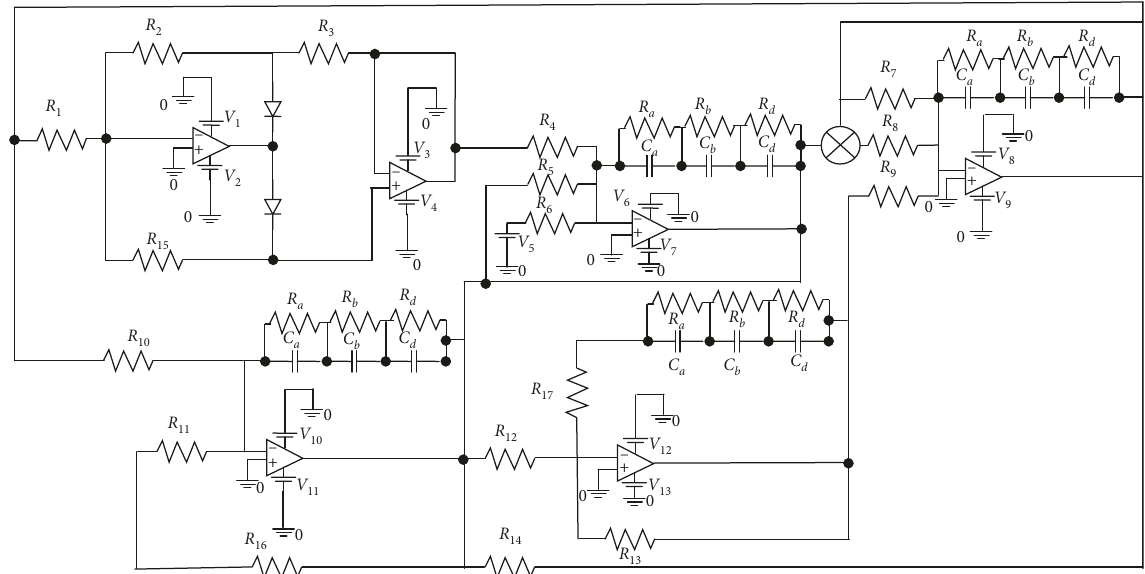
Figure 3: Simulation circuit of the